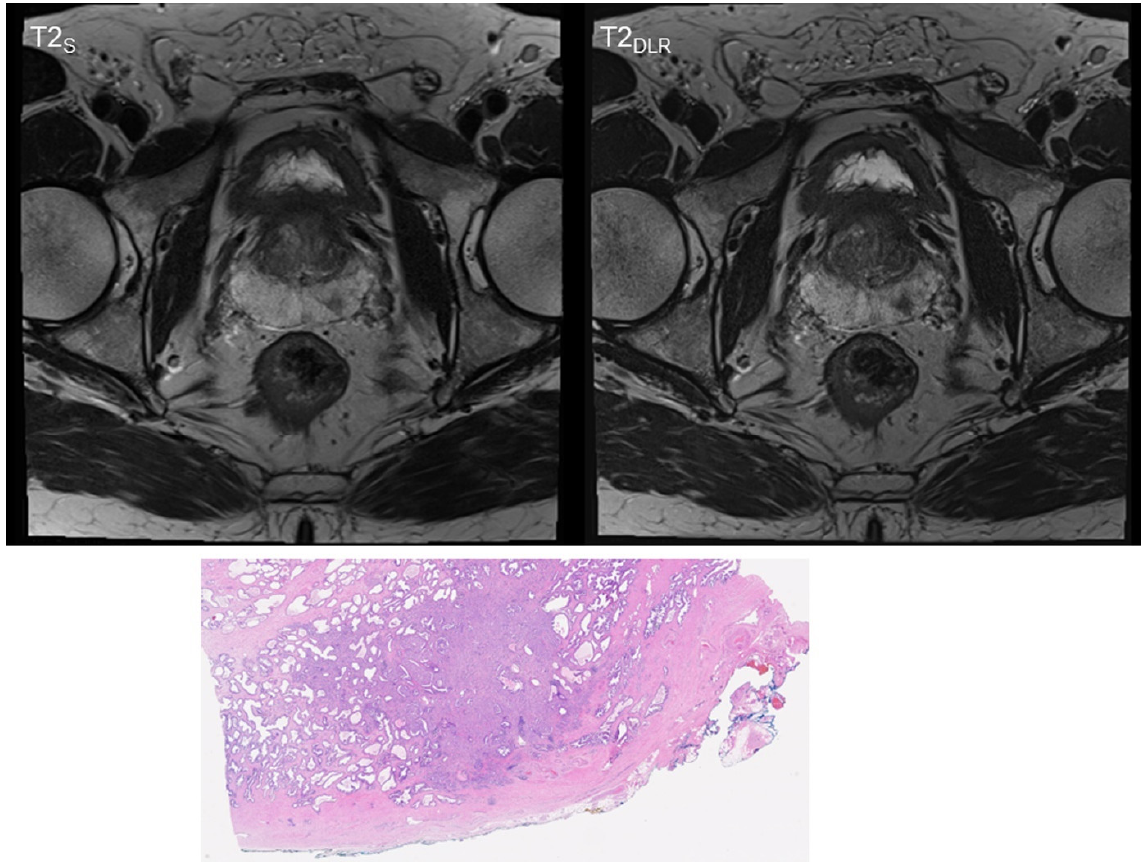
Figure 2. Sixty-three-year-old man with suspicion of prostate cancer. Deep learning image recon- structed thin-slice imaging (T2 DLR ) on the right-hand side with superior levels of sharpness and lesion detectability. PI-RADS 4 lesion in the left posterior peripheral zone. Biopsy was performed and resulted in Gleason 7a prostate carcinoma. The patient underwent prostatectomy that resulted in local T2 stage.